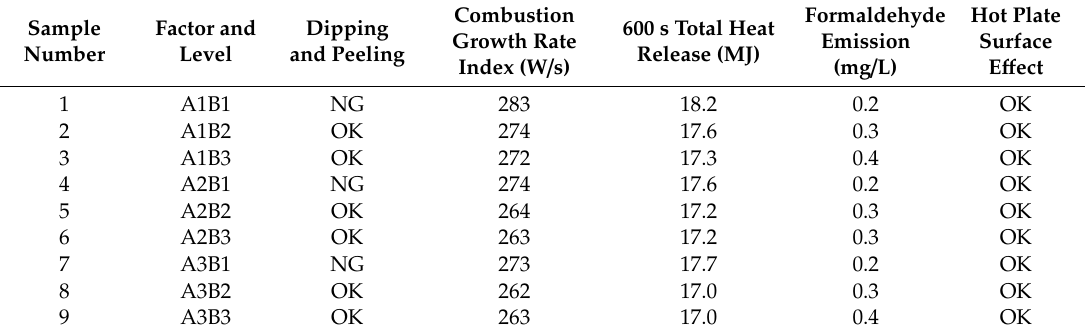
Table 4. Test results of one-time sizing optimization test.